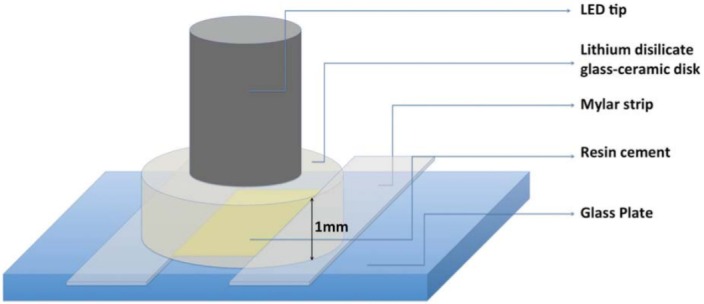
Experimental set up